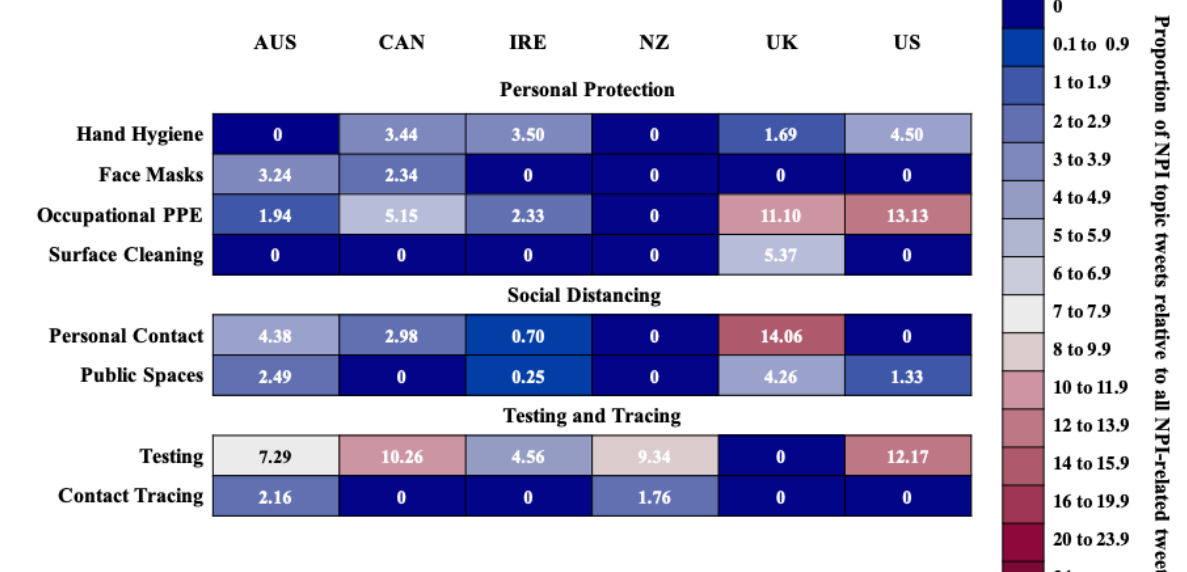
Figure 1. A heatmap of the proportions of tweets associated with less restrictive nonpharmaceutical interventions (NPIs) for each country. PPE: personal protective